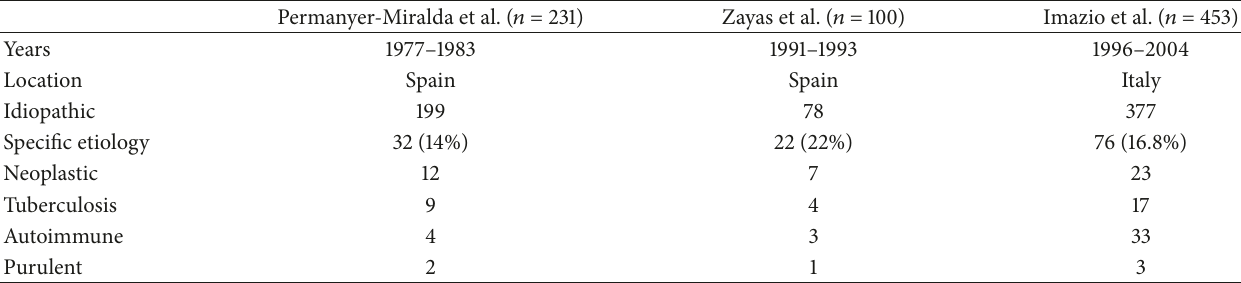
Table 2: Etiology of acute pericarditis: data from 3 large case